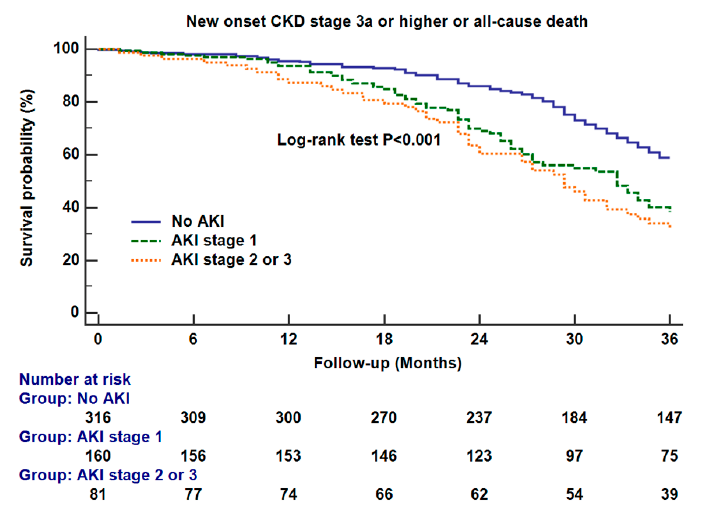
Figure 3. Kaplan–Meier survival curve analysis for new-onset chronic kidney disease stage 3a or higher (estimated glomerular filtration rate < 60 mL / min / 1.73 m 2 ) or all-cause mortality as the